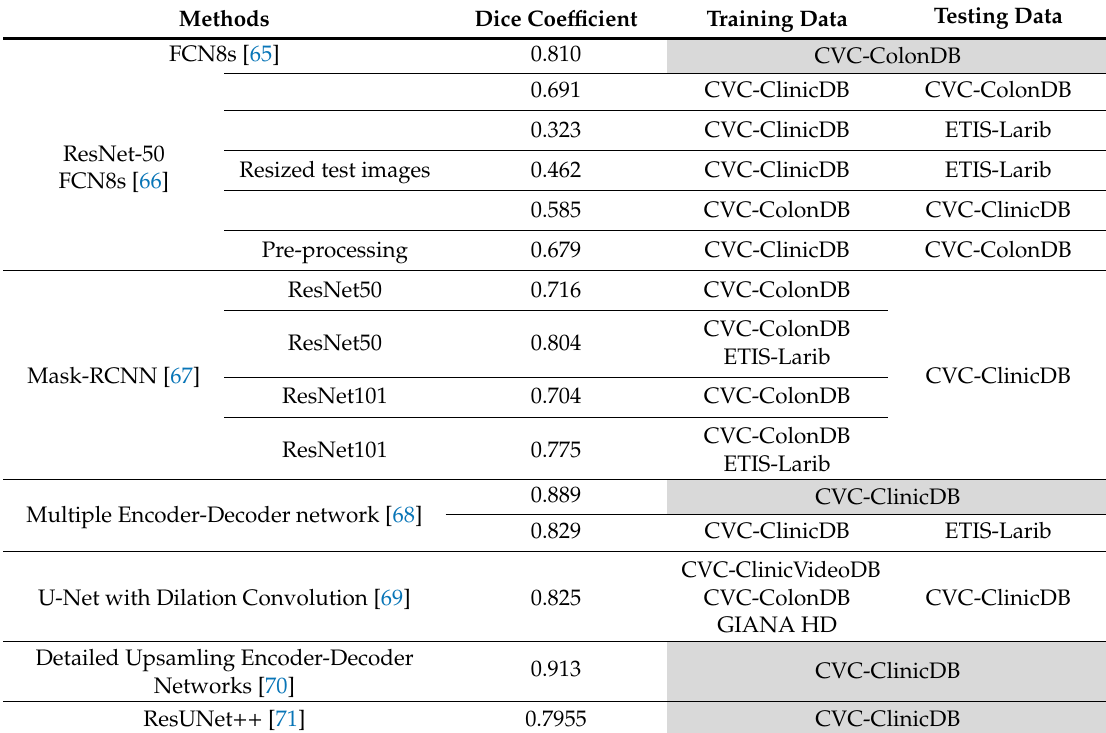
Table 4. The comparison of existing polyp segmentation